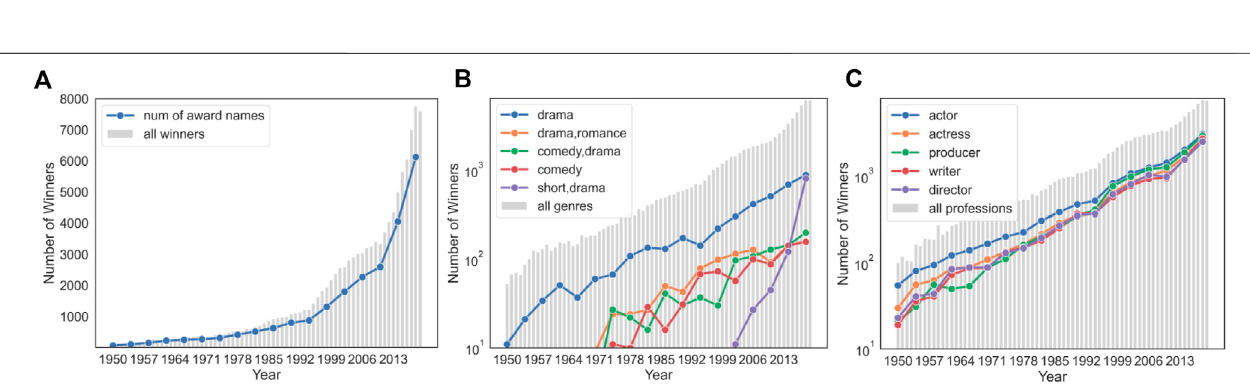
FIGURE3| Thenumberofawardwinnersbyyear (A) Thenumberofallawardwinnersincreases(greybar)whenthenumberofawardsincreases(dottedline)onan exponential scale (B) For awards conferred to movies, i.e., for fi lm awardees, different genres have exponential increases with different exponents. Grey bars represent the number of all awarded fi lms by year, and dotted lines indicate the number of annually awarded fi lms by different genres (C) For awards conferred to individuals, all professionshaveasimilarexponentofincrease.Greybarsrepresentthenumberofindividualawardwinnersbyyear,anddottedlinesindicatethenumberofannual award winners for different